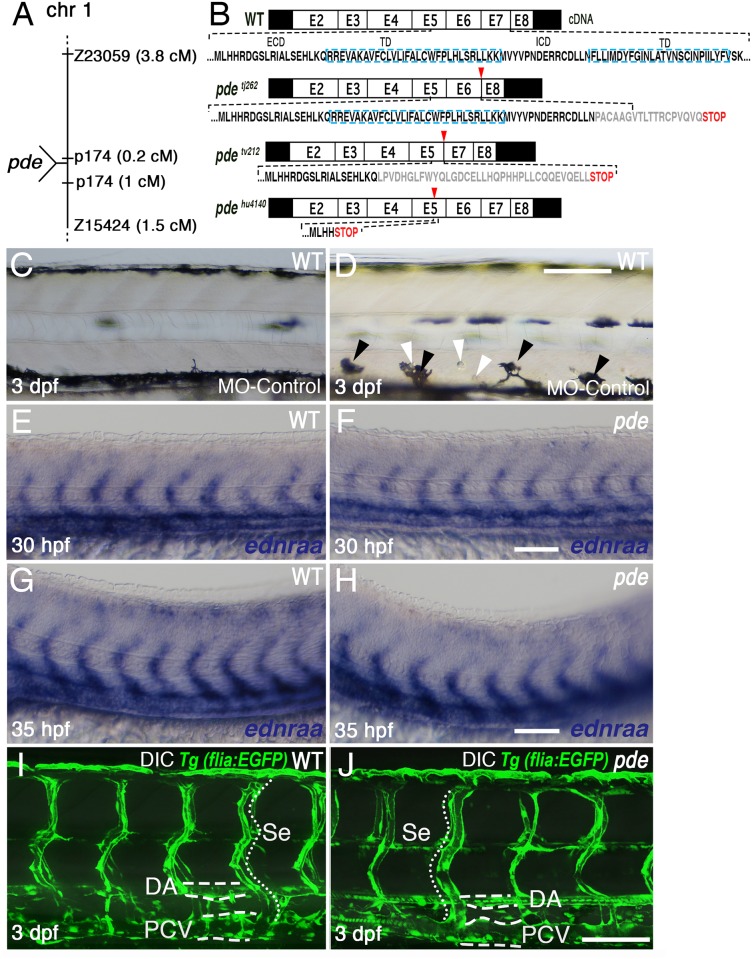
pde mutations affect ednraa, but not blood vessel formation and patterning.(A) pde map position on chromosome 1. (B) Schematic of predicted mRNA structure based upon sequencing of cDNA from pdetj262, pdetv212 and pdehu4140 mutants. cDNA of pdetj262 mutants lack exon 7, pdetv212 lack exon 6 and pdehu4140 have a transition mutation (AGA847TGA) that causes a premature translation stop (triangle) in the 3’ region of exon 5. Predicted changes to EdnrAa protein are shown with respect to relevant extracellular domain (ECD), transmembrane domains (TD) and intracellular domains (ICD) of the multipass receptor protein. The location of the ednraa splice-blocking morpholino (MO-ednraa)is indicated (red bar). (C-D) Injection of ednraa morpholino into WT embryos phenocopies pde mutant pigment phenotype. (C) WT embryos injected with a control morpholino (MO-control) display a normal phenotype. (D) WT sibling injected with MO-ednraa display ectopic melanocytes (black arrowheads) and iridophores (white arrowheads) in the ventral medial pathway. (E-H) Whole mount in situ hybridization of ednraa at 24 hpf and 36 hpf is restricted to the developing blood vessels, and is indistinguishable between pde mutants (F and H) and their WT siblings. (I-J) Imaging of blood vessels in the posterior trunk using the transgenic reporter flia:GFP shows no difference in blood vessel morphology between WT siblings (I) and pde mutants (J). DA, Dorsal Aorta; PCV, Posterior Cardinal Vein; Se, Segmental Vessels. Scale bar = 100 μm (C,D, E and J) and 25μm (E-H).